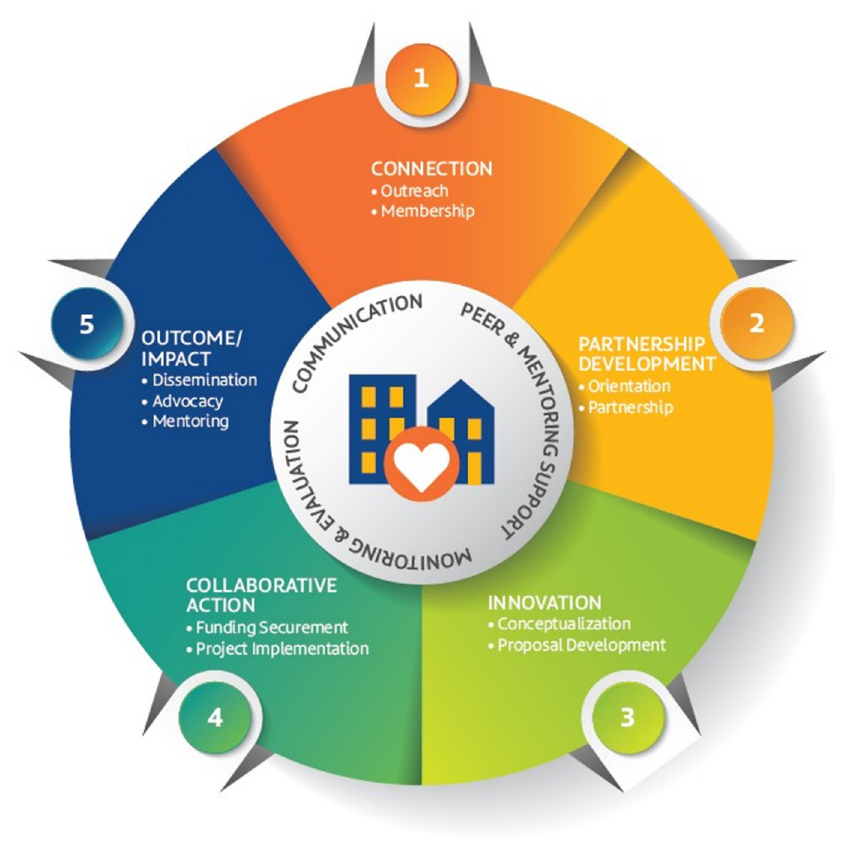
Figure 1. Morgan CARES